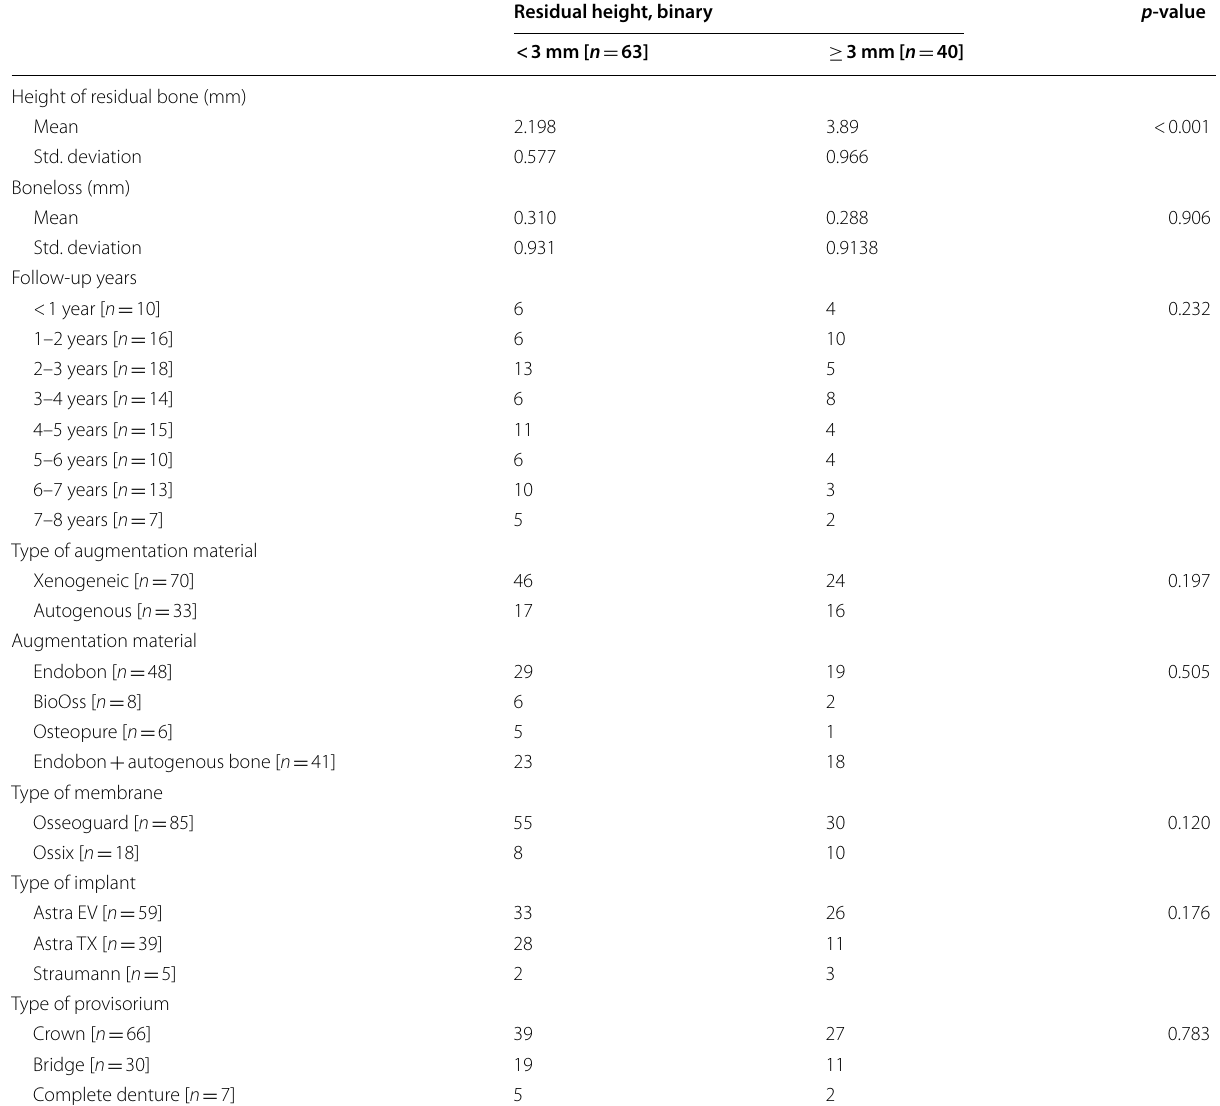
Table 1 Diagnostic and surgical characteristics of the study population